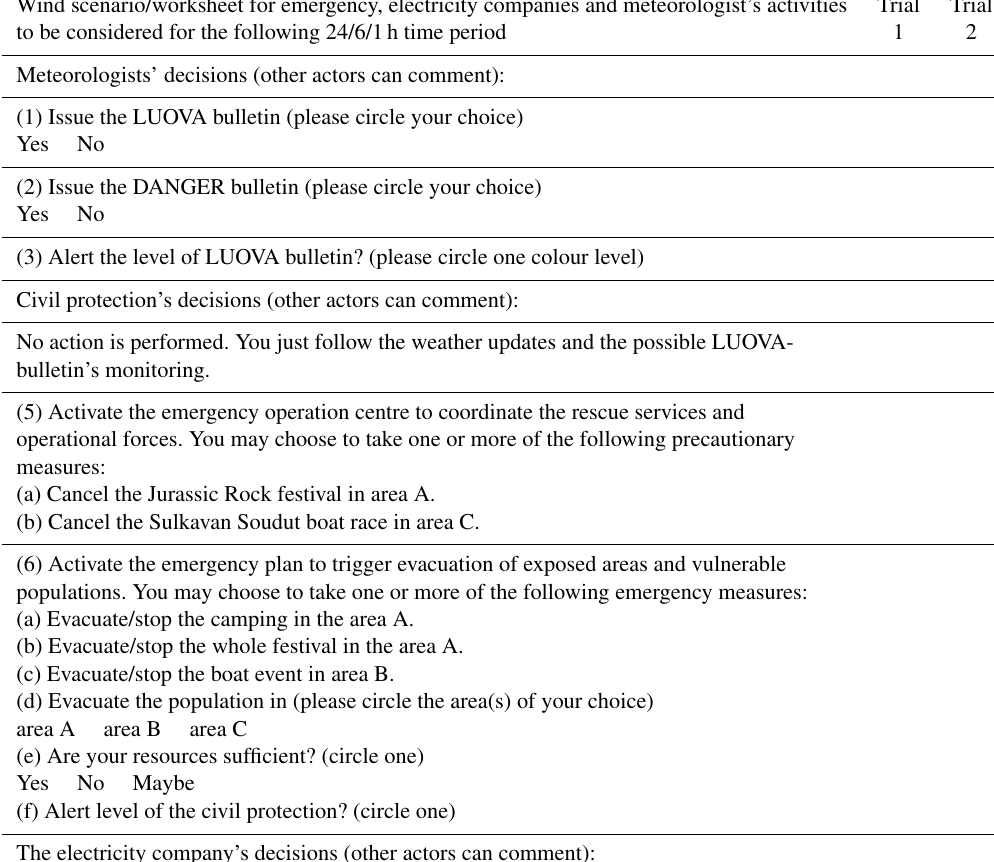
Table A2. Worksheet with predefined list of emergency and communication activities delivered to players of the wind scenario. Wind scenario/worksheet for emergency, electricity companies and meteorologist’s activities Trial Trial to be considered for the following 24/6/1h time period 1